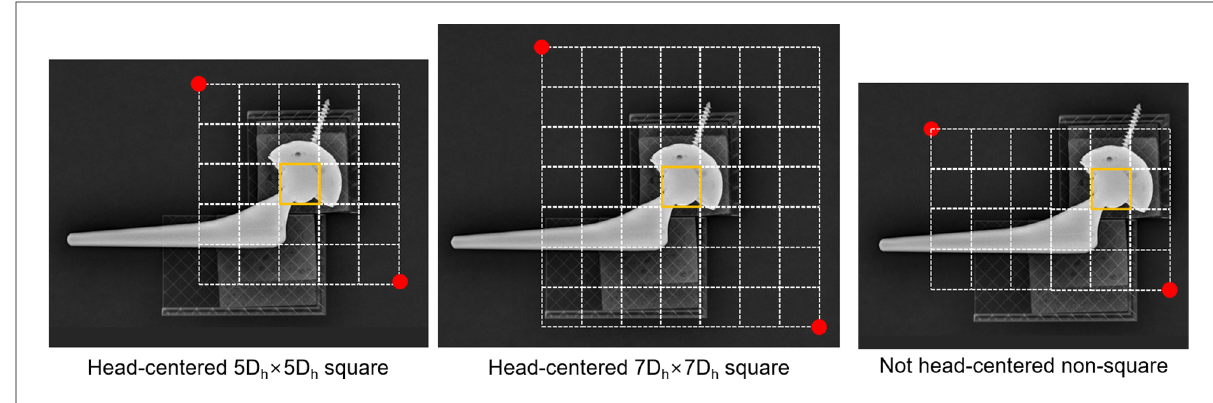
FIGURE 7 Three ways of specifying the edge detection area. The edge detection area was assigned as a rectangle whose edge lengths were 5 times (5 D h ) square, 7 times (7 D h ) square of the diameter of the femoral head component ( D h ), or non-square. The square areas speci fi ed were centered in the middle of the FH, whereas non-square ones were off the FH